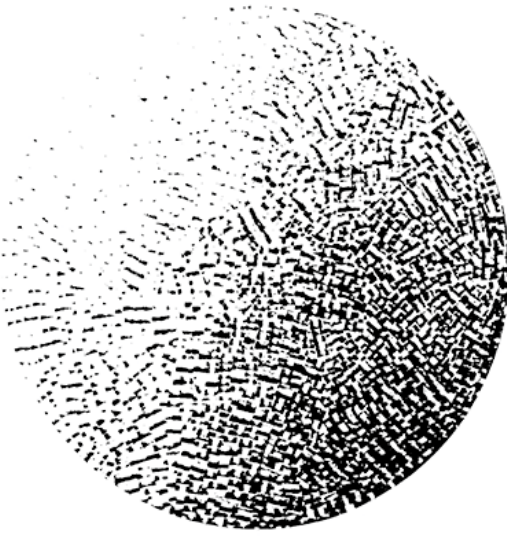
Figure 2. Wolfgang Weingart, round composition, lead type used to fill up a cardboard tube and then printed on their reversed sides, 1963.